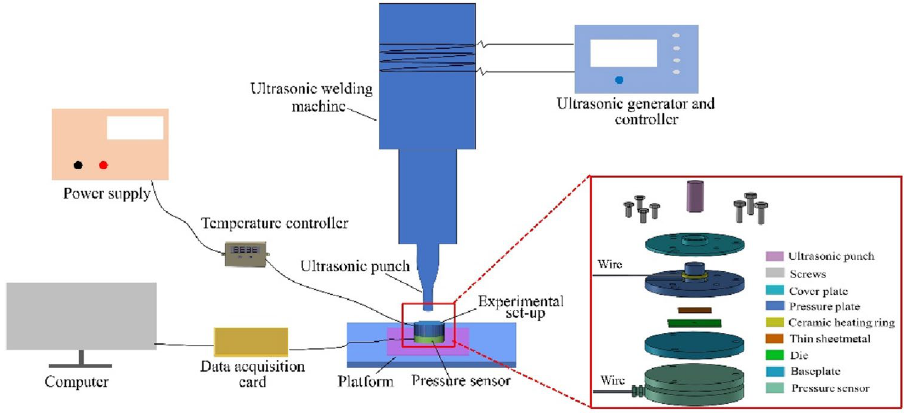
Figure 2. Schematic diagram of Micro-USF micro-punching experimental platform.